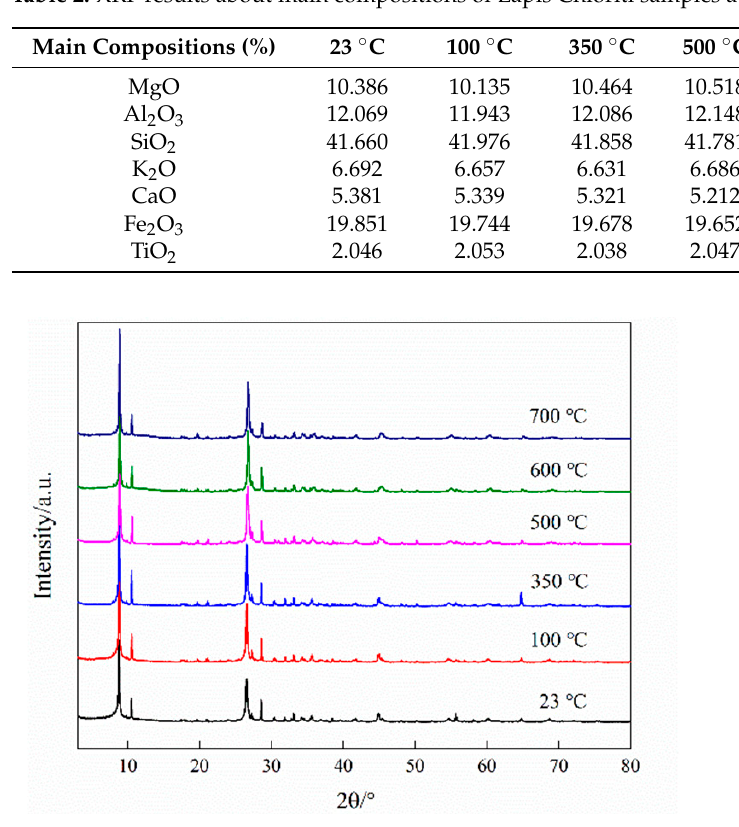
Figure 4. The XRD patterns of the Lapis Chloriti sample after calcination at different temperatures. Table 2. XRF results about main compositions of Lapis Chloriti samples at different